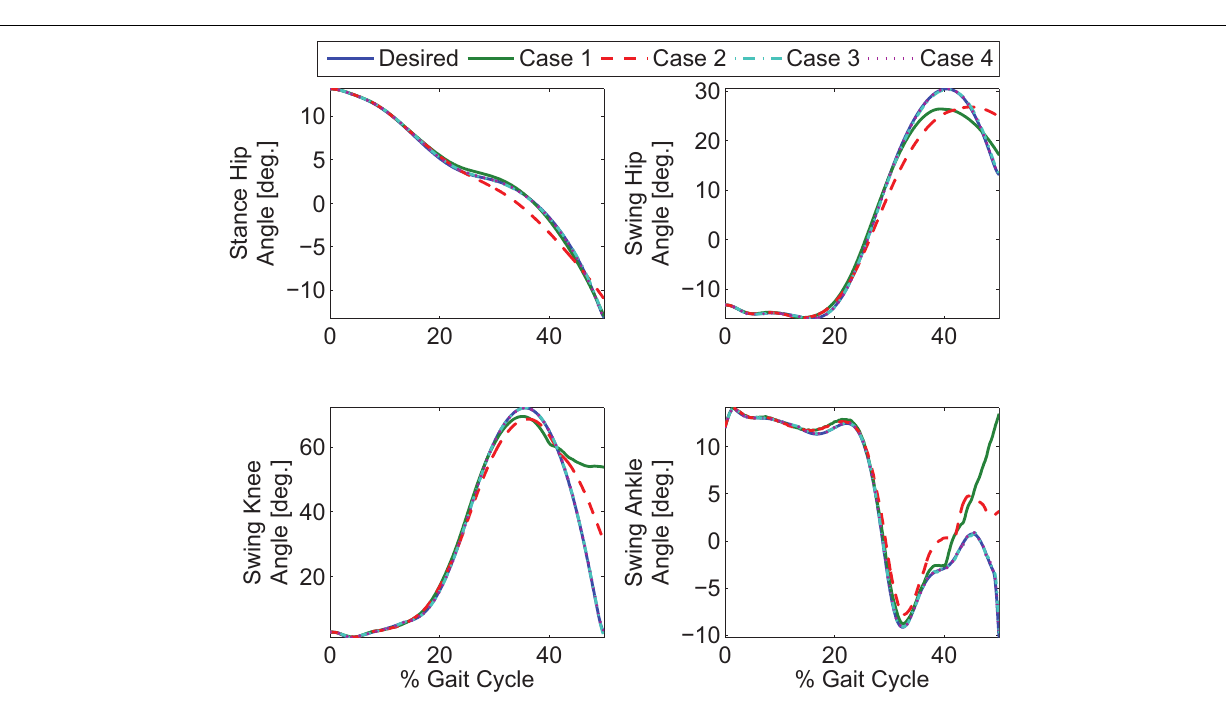
FIGURE 6 | Four cases for gait control using a hybrid neuroprosthesis . Case 1 only used the feedforward synergies, Case 2 used the adapted feedforward synergies, Case 3 considered both the adapted feedforward synergies and feedback control, and Case 4 used the full optimal inputs and feedback control. Note that the profile from the third and fourth cases almost perfectly overlaps the desired